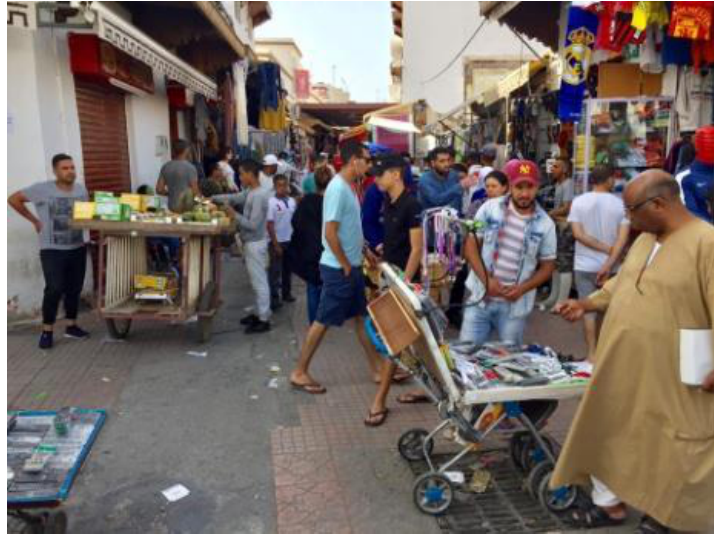
Figure 7: informal economic activities-the médina of Bab El